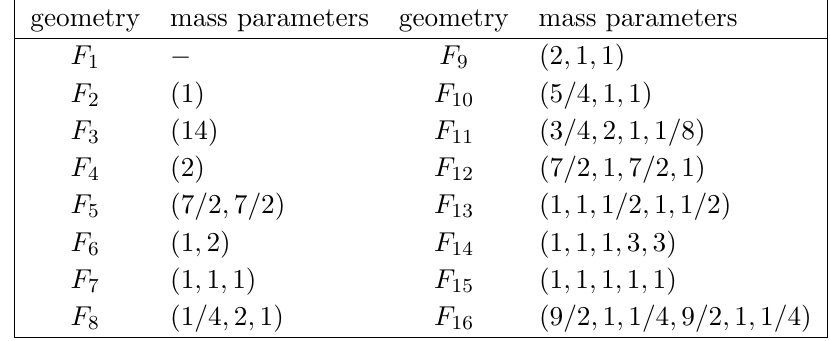
Table 2 . Choices of mass parameters. An entry ( c 1 ; c 2 ; : : : ) means the mass parameters take values ( m 1 ; m 2 ; : : : ) = ( c 1 ; c 2 ; : : :